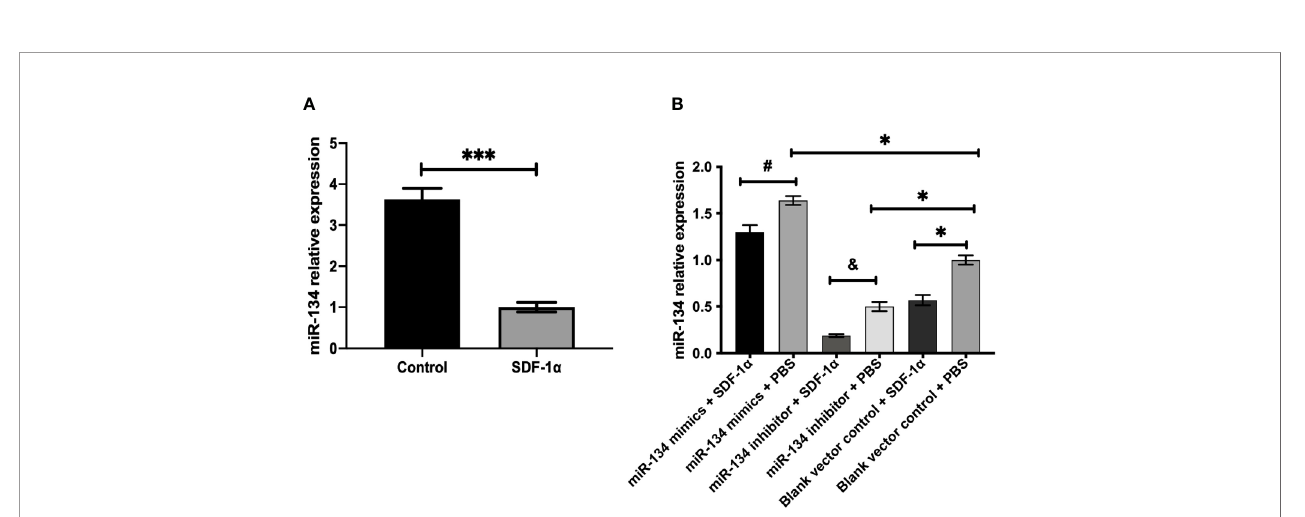
FIGURE 2 | SDF-1 a inhibits the expression of miR-134. a T3-1 cells were treated with SDF-1 a , control, miR-134 mimics + SDF-1 a , miR-134 mimics + PBS, miR- 134 inhibitor + SDF-1 a , miR-134 inhibitor + PBS, black vector control + SDF-1 a , black vector control + PBS, respectively. (A, B) MiR-134/U6 relative level in a T3-1 cells by qRT-PCR. Data were represented as means ± SD (n = 3). ***p < 0.001 vs. control group. # p < 0.05 vs. miR-134 mimics + PBS group. & p < 0.05 vs. miR- 134 inhibitor + PBS group. *p < 0.05 vs. black vector control + PBS